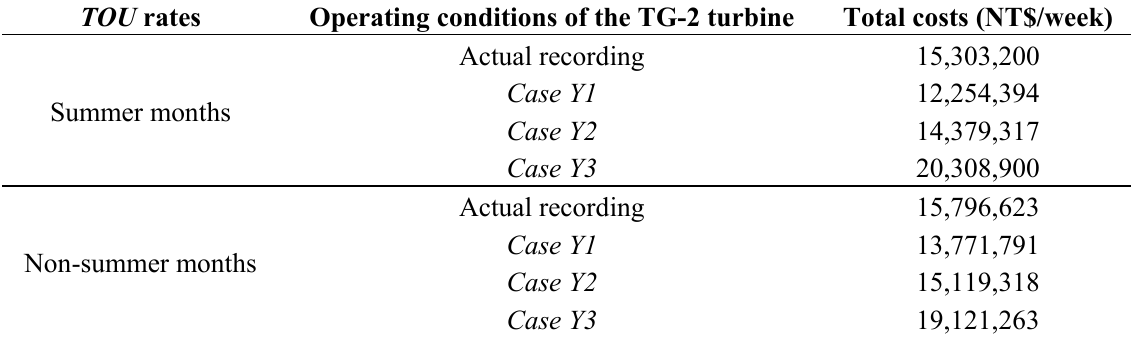
Table 10. Comparison of total costs under different operating